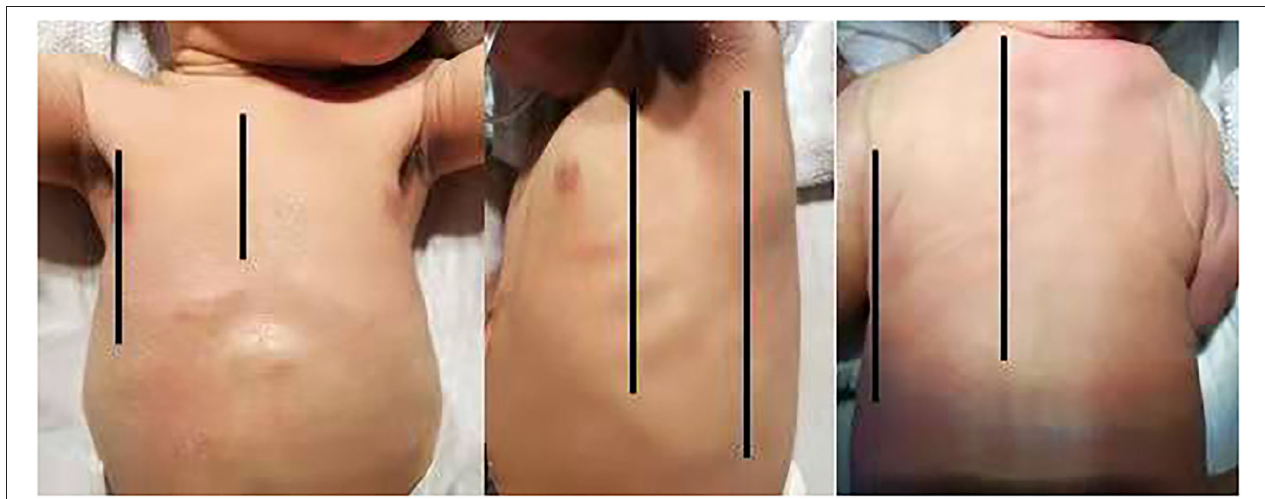
FIGURE 1 | The chest surface was divided into three regions by the anterior and posterior axillary lines as boundaries: anterior region (from parasternal to anterior axillary line), lateral region (from anterior to posterior axillary line), and posterior region (from posterior axillary to paravertebral line).